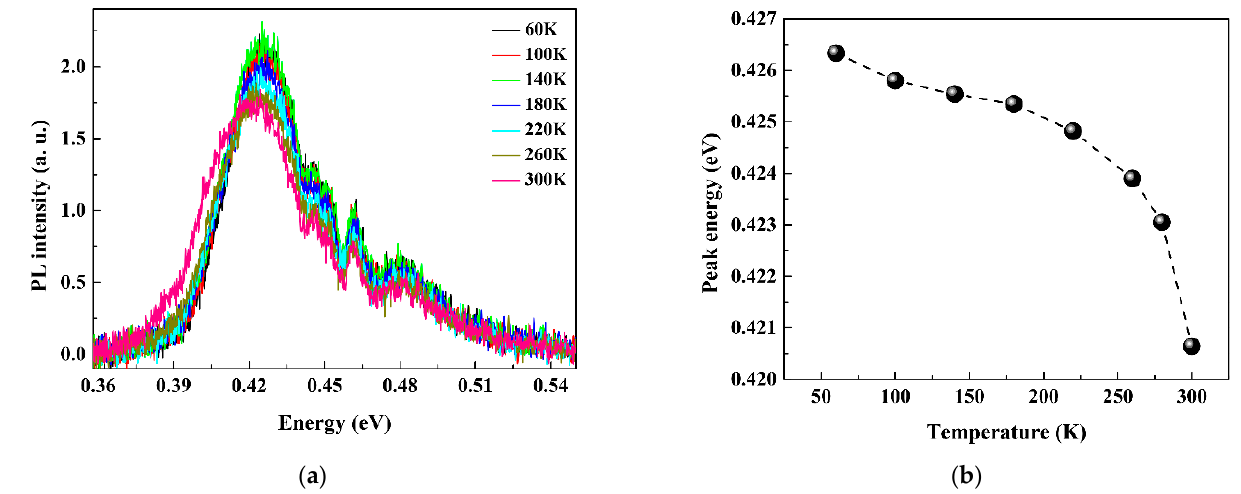
Figure 8. ( a ) PL spectra for different temperatures range of 60–300 K; ( b ) variation in peak point of PL spectra for different